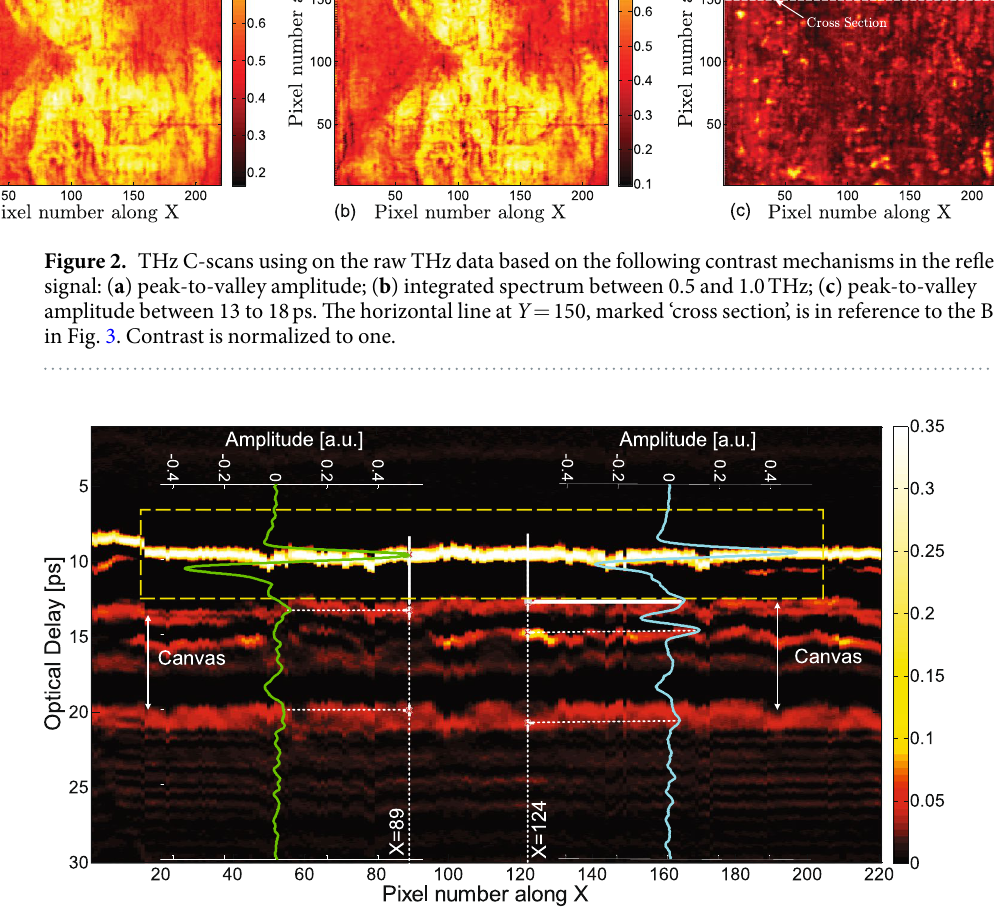
Figure 3. The THz B-scan based on the amplitude of raw signals with the cross-section Y = 150. Two typical THz reflected signals are plotted corresponding to the THz B-scan, with the waveform at pixel (89, 150) in green and the waveform at pixel (124, 150) in